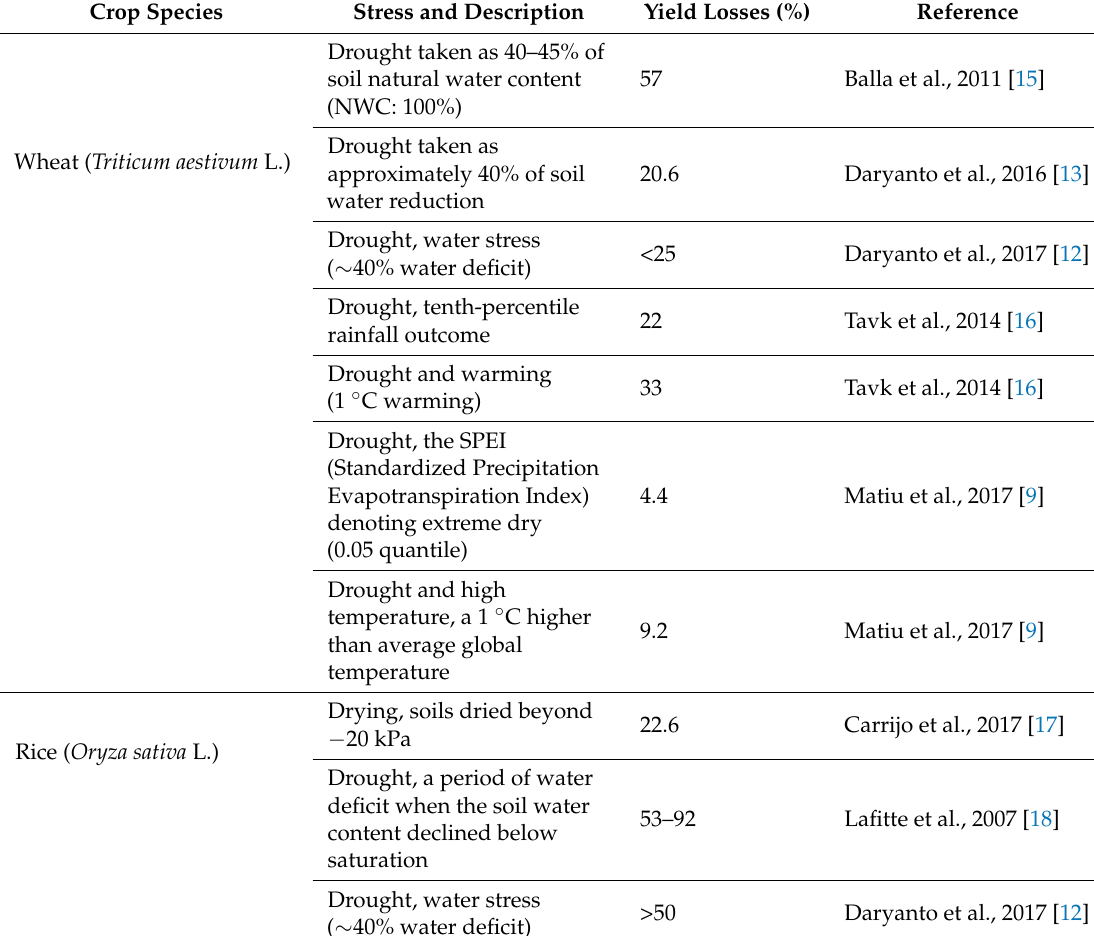
Table 1. Yield losses in wheat and rice caused by